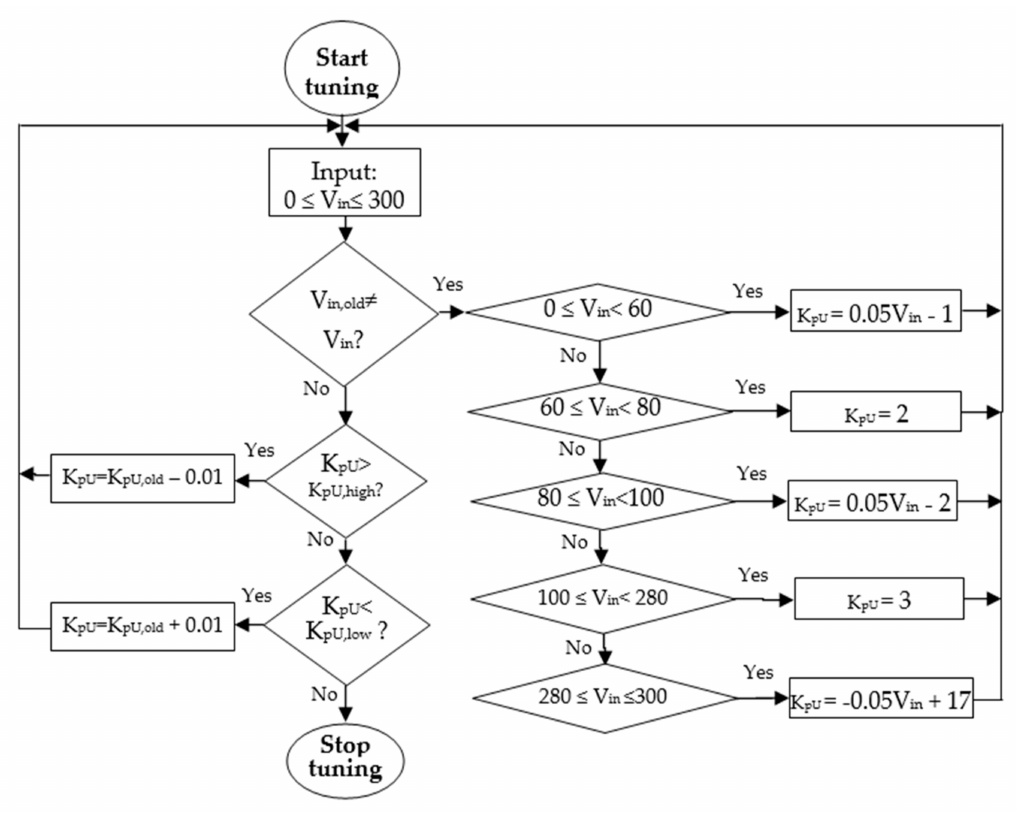
Figure 6. Online tuning mechanism for the upper part of buck-boost